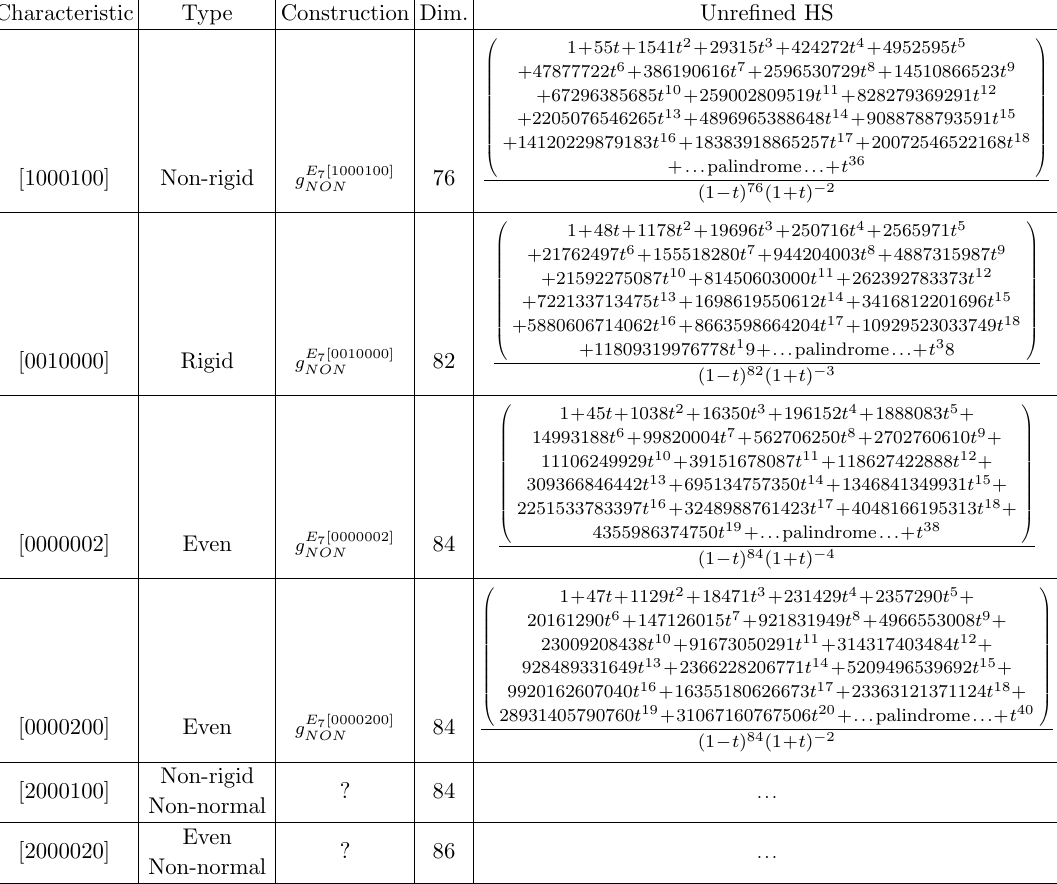
Table 19 . E 7 orbit constructions and Hilbert series